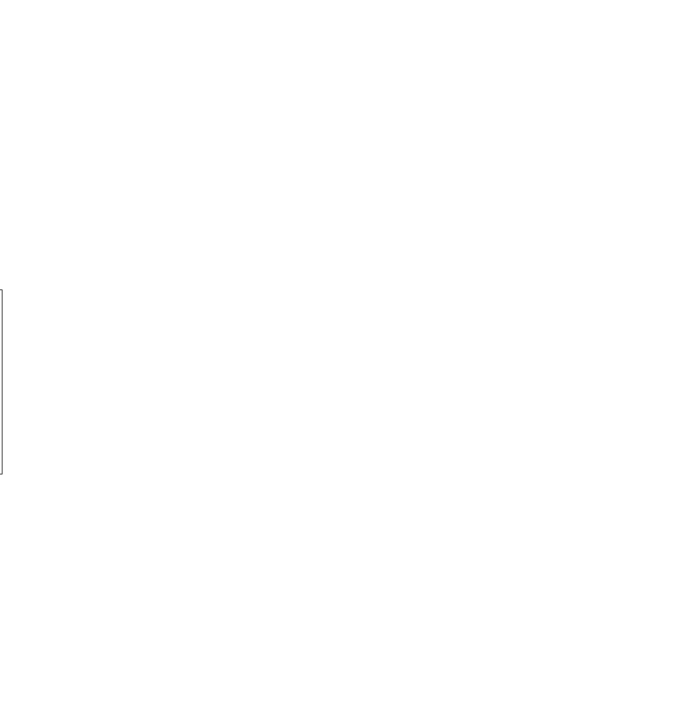
Figure 3. Flowchart describing data preprocessing, data augmentation and model training steps. Each of the datasets are constructed by extracting the reference charge profiles from the raw data. After preprocessing, the 28 datasets are split into train and testing datasets. The train set is then augmented as described in Section 3 before training begins. Please refer to text for more details.